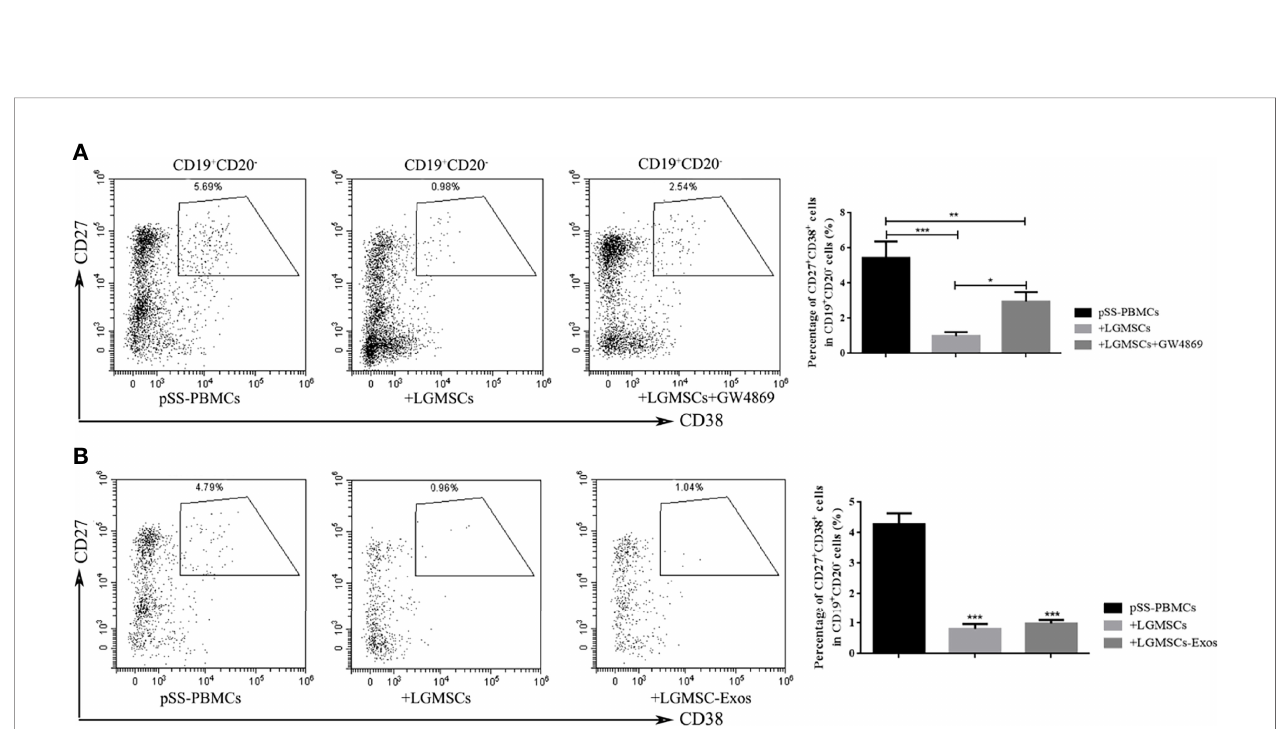
FIGURE 4 | LGMSC-Exos inhibited the percentage of CD19 + CD20 - CD27 + CD38 + plasma cells in the co − culture system in vitro . (A) The proportion of CD19 + CD20 - CD27 + CD38 + plasma cells in PBMCs from patients with pSS co-cultured with LGMSCs and treated LGMSCs treated with GW4869. Data represent the mean ± standard deviation (SD; n = 3 independent experiments). ***p < 0.001, **p < 0.01, *p < 0.05. (B) The proportion of CD19 + CD20 - CD27 + CD38 + plasma cells among PBMCs from patients with pSS co-cultured with LGMSCs and LGMSC-Exos. Data represent the mean ± standard deviation (SD; n = 3 independent experiments). ***p < 0.001, in comparison with the untreated